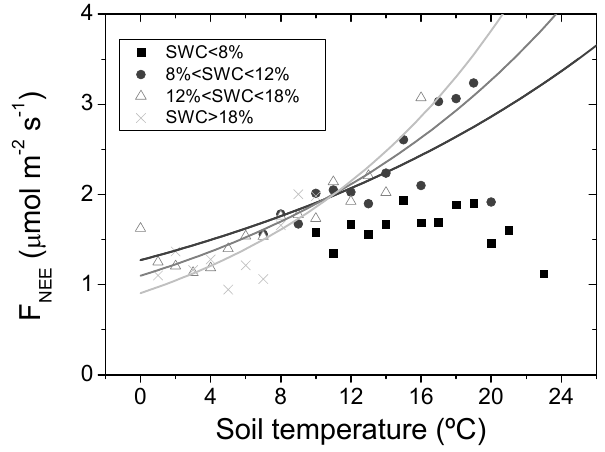
Fig. 6a. Mean nocturnal NEE in 2007 vs. soil temperature Figure 6a. Mean nocturnal NEE in 2007 vs soil temperature for different soil water for different soil water contents classes. Three classes of SWC contents classes. Three classes of SWC (those for SWC > 8 %) were fitted to exponential (those for SWC > 8%) were fitted to exponential dependency dependency with soil temperature (fine line: SWC > 18%; medium line: 12% < SWC < with soil temperature (fine line: SWC > 18%; medium line: 18%; dark line: 8% < SWC < 12%). No good agreement was found for SWC < 8 %. 12% < SWC < 18%; dark line: 8% < SWC < 12%). No good agreement was found for SWC < 8%.